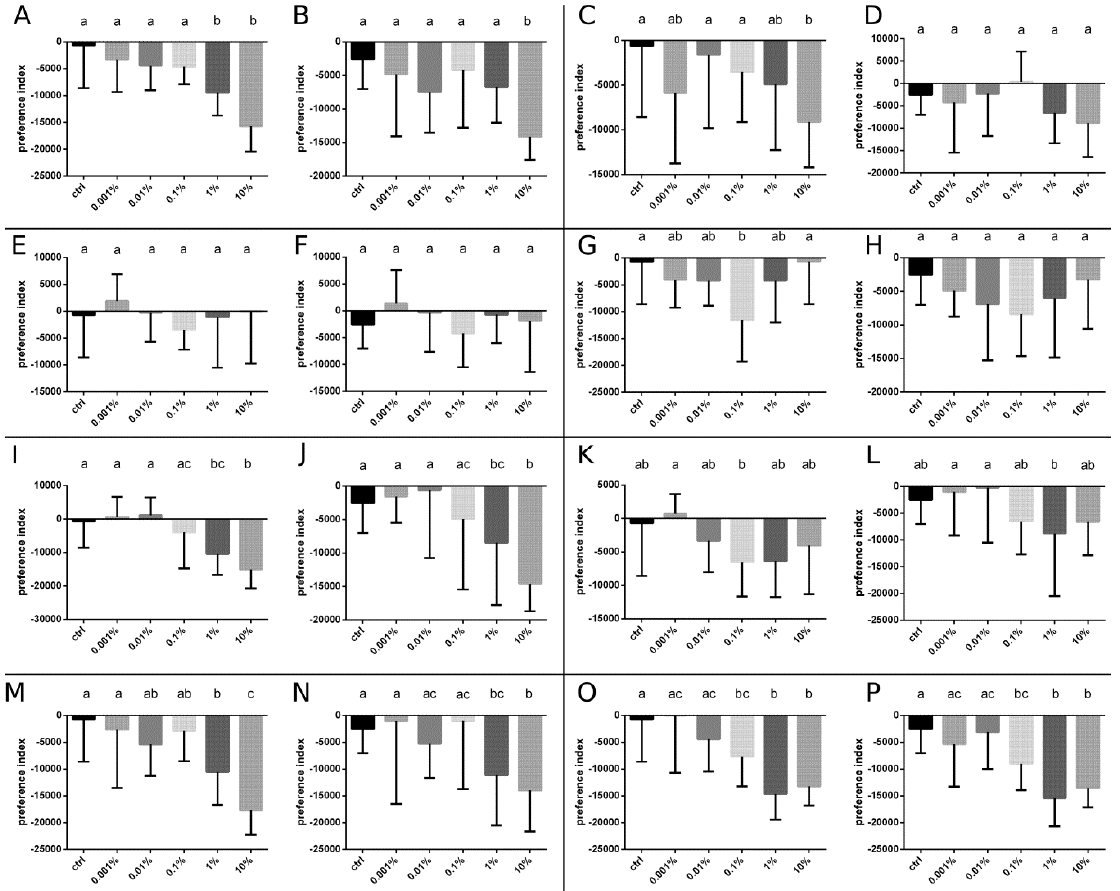
Figure 2. Preference index (PI) for insects treated with a single essential oil or a mixture (1:1 or 1:1:1) of essential oils in different concentrations and the control. Median and quartiles are presented, Kruskal-Wallis test p < 0.05. Different letters indicate statistically different groups. Different letters indicate statistically different groups. Citronella EO ( A ) interval 1, ( B ) interval 2; lemon EO ( C ) interval 1, ( D ) interval 2; mint EO ( E ) interval 1, ( F ) interval 2; vanilla EO ( G ) interval 1, ( H ) interval 2; 1:1 mix of citronella and lemon EOs ( I ) interval 1, ( J ) interval 2; 1:1 mix of citronella and vanilla EOs ( K ) interval 1, ( L ) interval 2; 1:1 mix of vanilla and lemon EOs ( M ) interval 1, ( N ) interval 2; 1:1:1 mix of vanilla, citronella and lemon EOs ( O ) interval 1, ( P ) interval